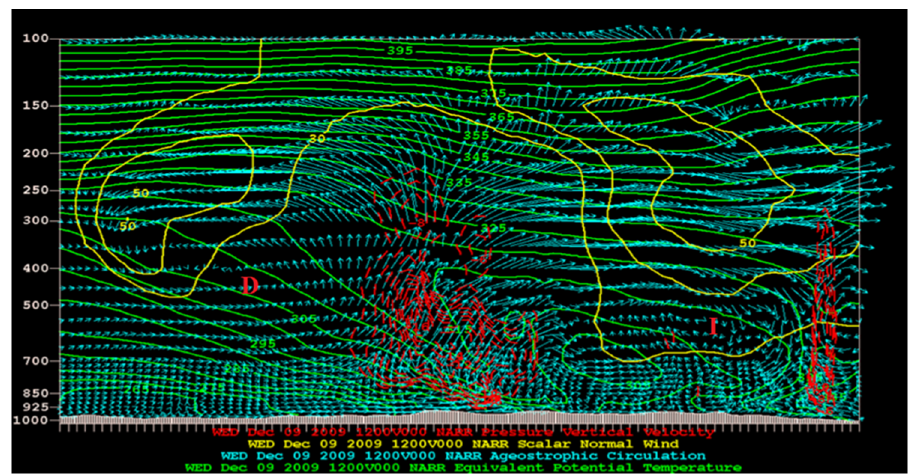
Figure 3. Cross section through a RDDOZ on 1200 UTC 9 December 2009. Dashed green lines are values of equivalent potential temperature ( θ e ) every 5 K. Light blue arrows are ageostrophic circulation vectors. Solid yellow lines are isotachs normal to the cross section 10 m·s − 1 . D and I represent the thermally direct (downstream) and indirect (upstream) circulations, respectively. Red arrows represent vertical velocity vectors.